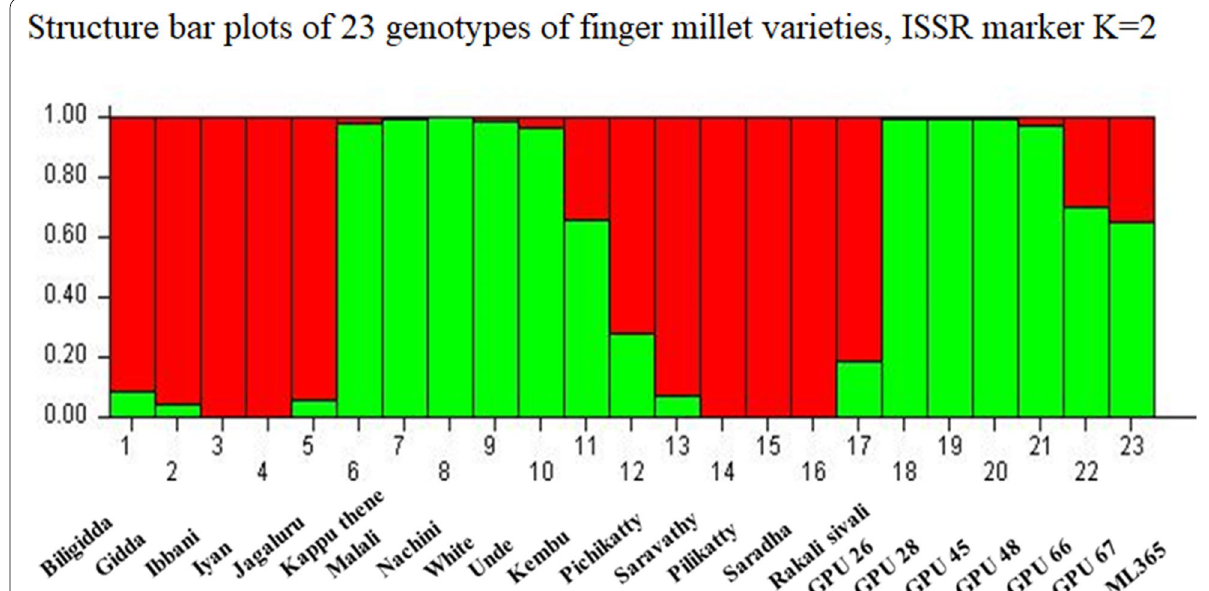
Fig. 4 Structure bar plots of 23 genotypes of finger millet varieties, ISSR marker K